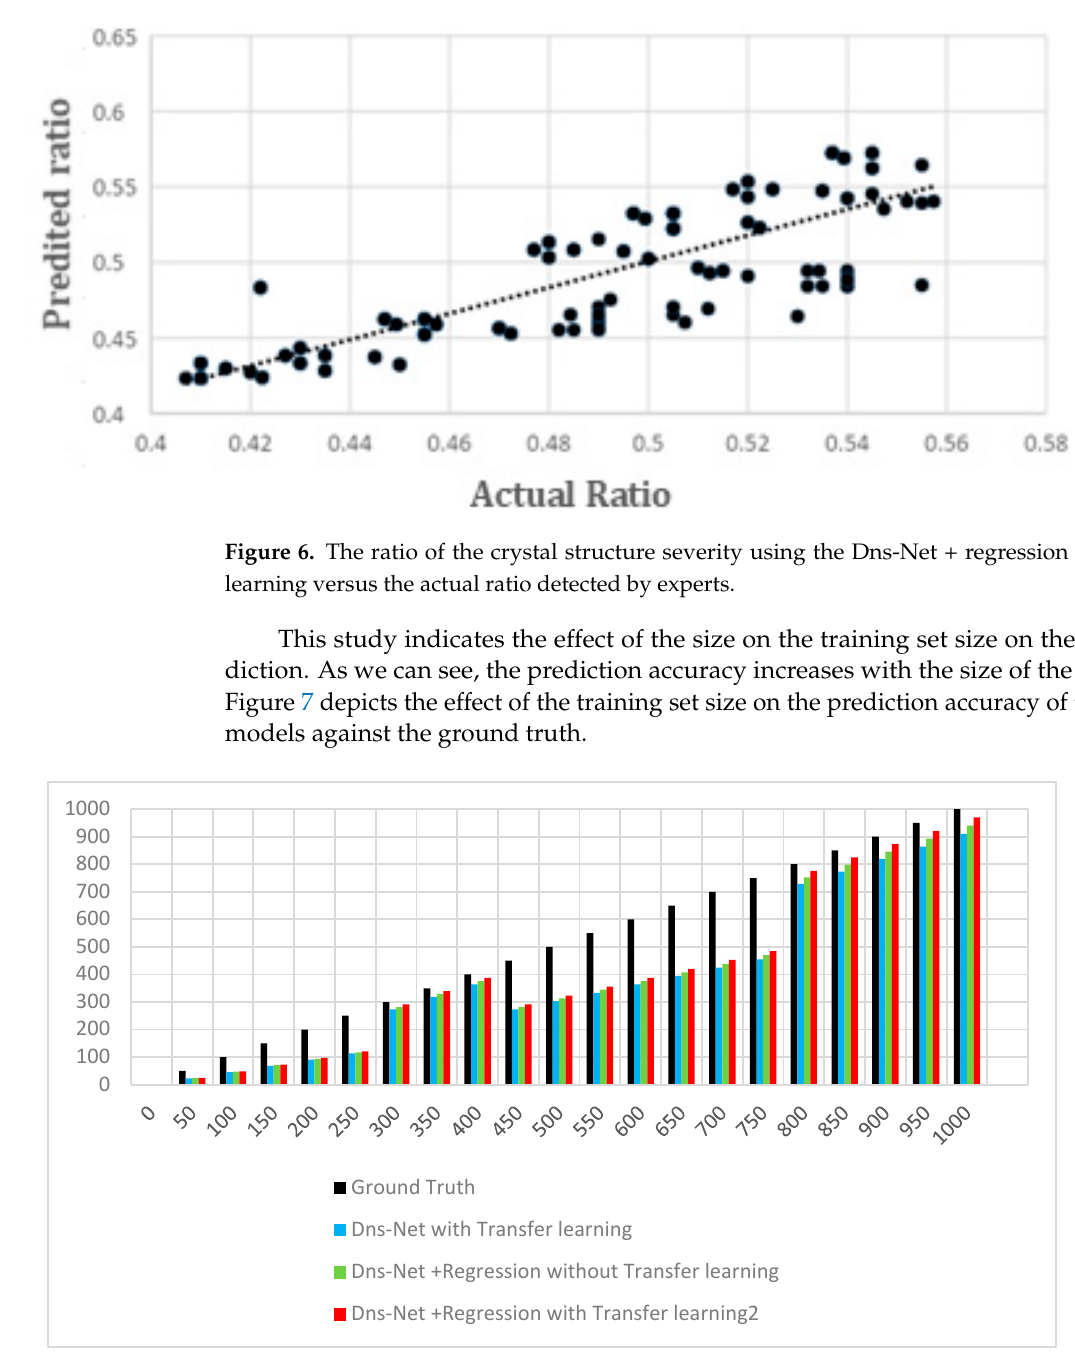
Figure 6 denotes the correlation between the computational ratio of the crystal struc- tures severity of the predicted classes using the Dns-Net + regression with transfer learning versus the actual ratio detected by experts.